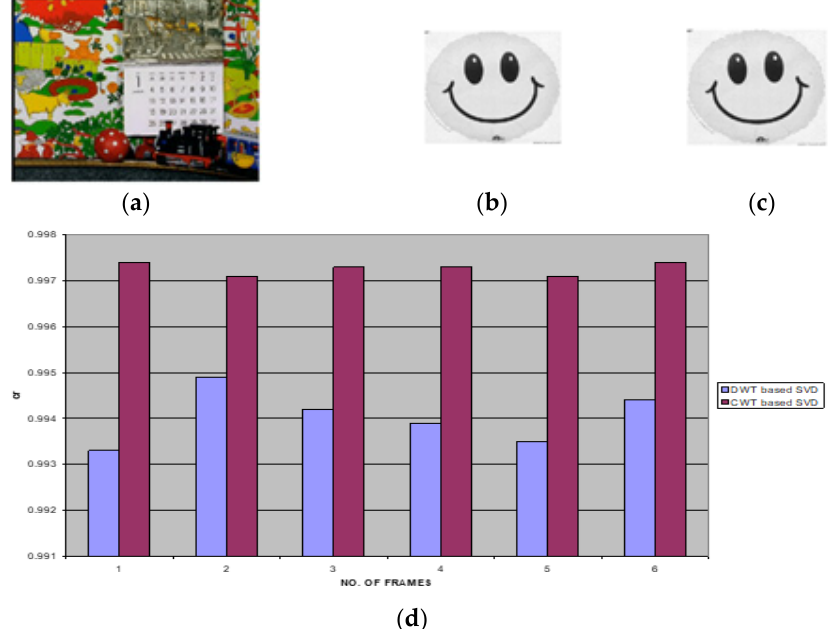
Figure 18. ( a ) The watermarked frame using the proposed method. ( b ) Extracted watermark from frame 10 of second video in the proposed method. ( c ) Extracted watermark from frame 10 of the second video scene for the DWT-based SVD method. ( d ) Correlation values for the extracted watermarks from each frame in the second video scene without attack.